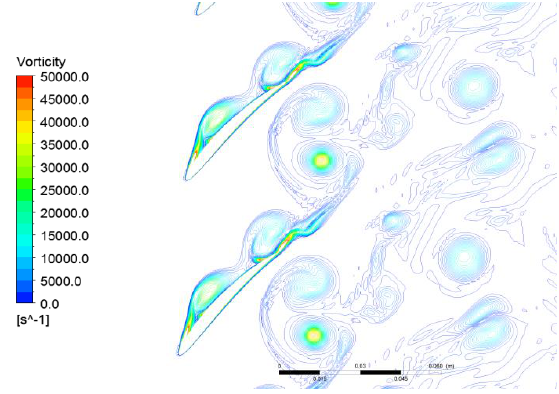
Figure 16. Instantaneous vorticity contour with excitation at 7 times the RF.